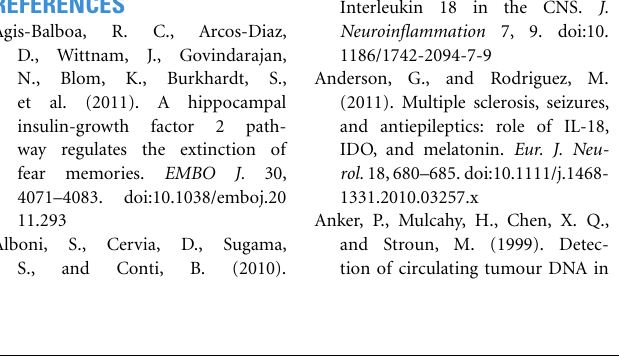
Table S2 | Generalized linear models investigating the adjusted means ∗ and differences between cases and controls, pre-deployment and